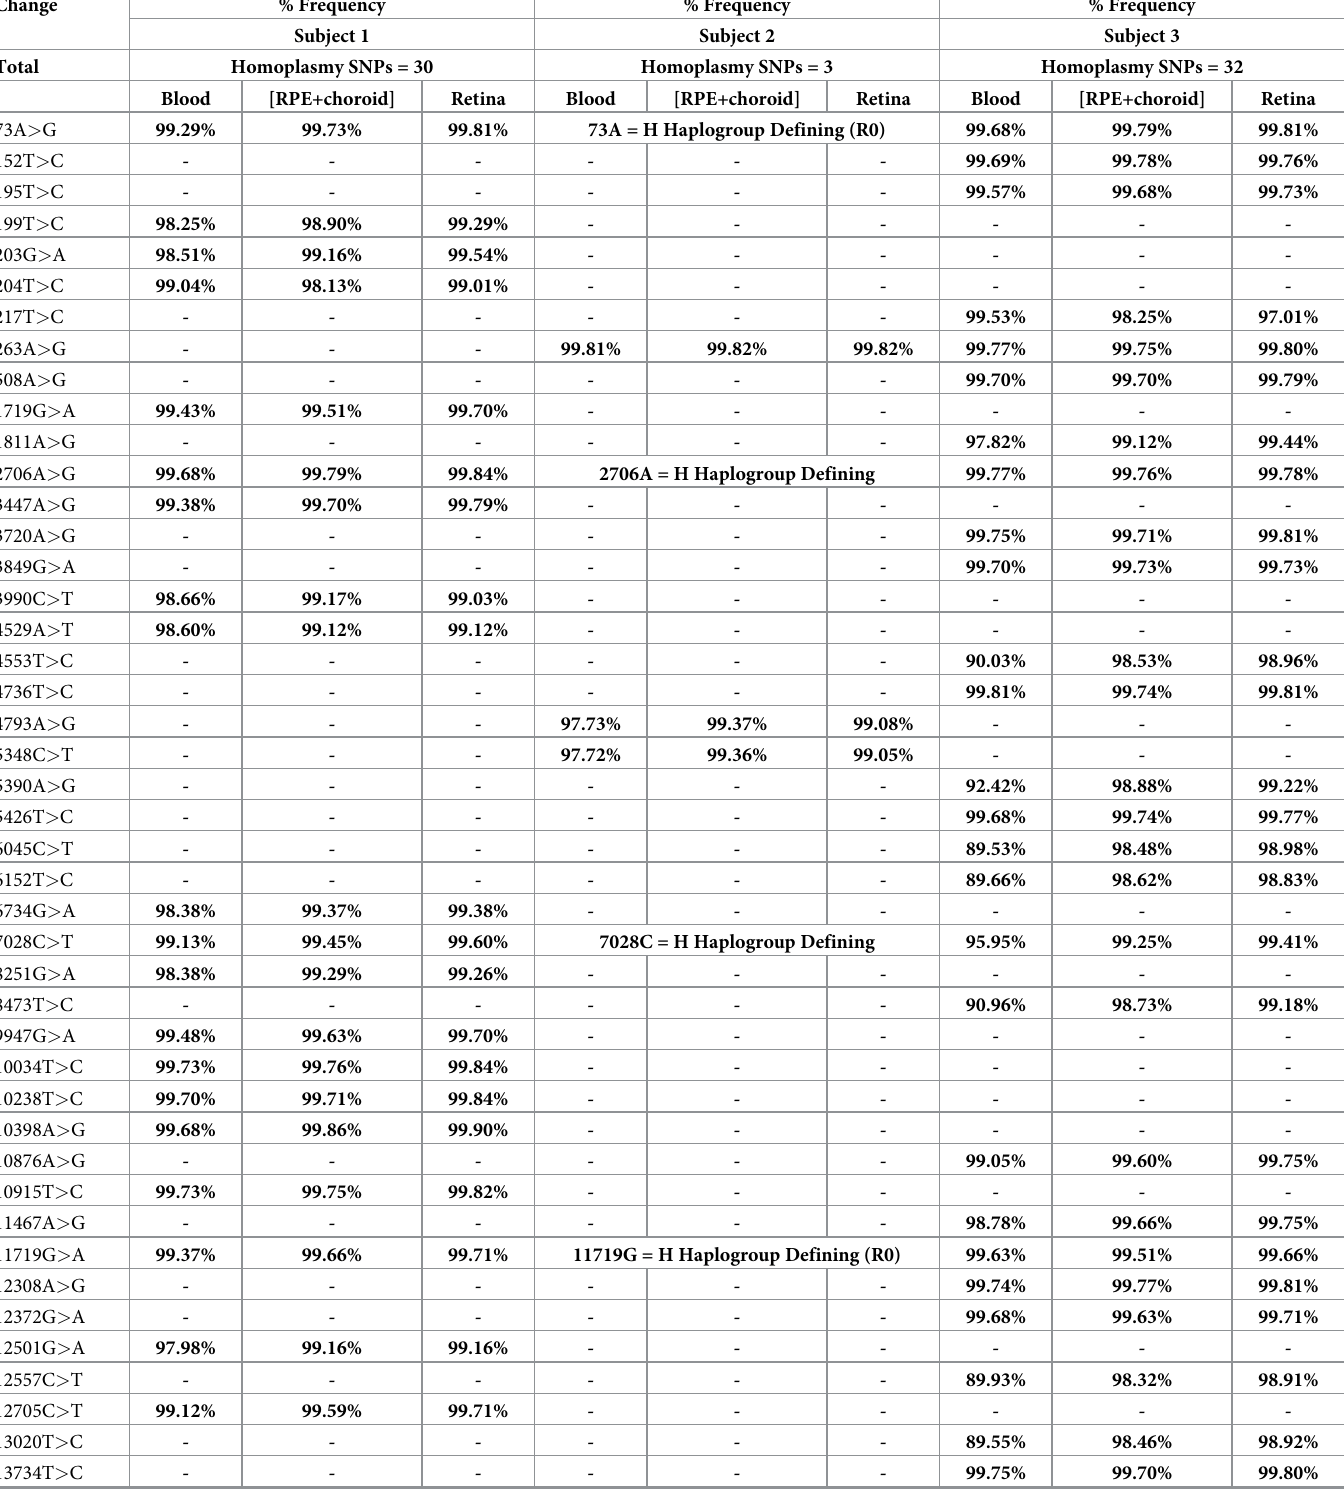
Table 3. List of homoplasmy SNPs found in different tissues and subjects.